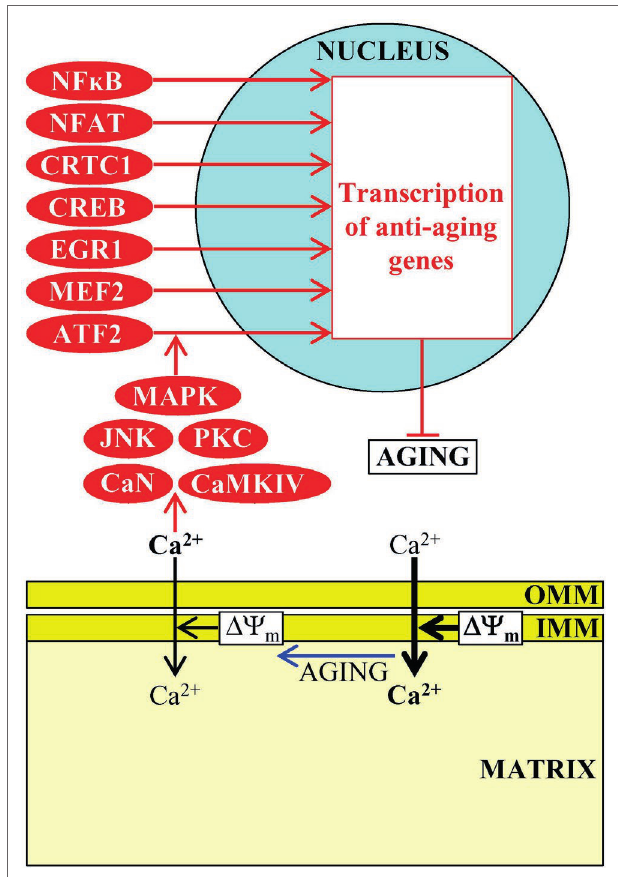
FIGURE 7 | Ca 2+ uptake and efflux by mitochondria contribute to aging- associated pathologies. An aging-associated decline in mitochondrial functionality causes a rise in cytosolic Ca 2+ concentration. In the cytosol, Ca 2+ initiates a cascade of events that establish an aging-delaying gene transcription pattern in the nucleus. Activation arrows and inhibition bars denote anti-aging processes and are displayed in red color. Anti-aging proteins are displayed in red color. See the text for additional details. Abbreviations: ATF2, activating transcription factor 2; CaMKIV, calmodulin-dependent protein kinase type IV; CaN, calcineurin; CREB, cAMP-responsive element binding protein; CRTC1, CREB-regulated transcription coactivator 1; EGR1, early growth response protein 1; IMM, inner mitochondrial membrane; JNK, c-Jun N-terminal protein kinase; MAPK, mitogen-activated protein kinase; MEF2, myocyte enhancer factor 2; NFAT, nuclear factor of activated T-cells; NF κ B, nuclear factor kappa B; OMM, outer mitochondrial membrane; PKC, protein kinase C; Δ Ψ m , the electrochemical potential across the inner mitochondrial